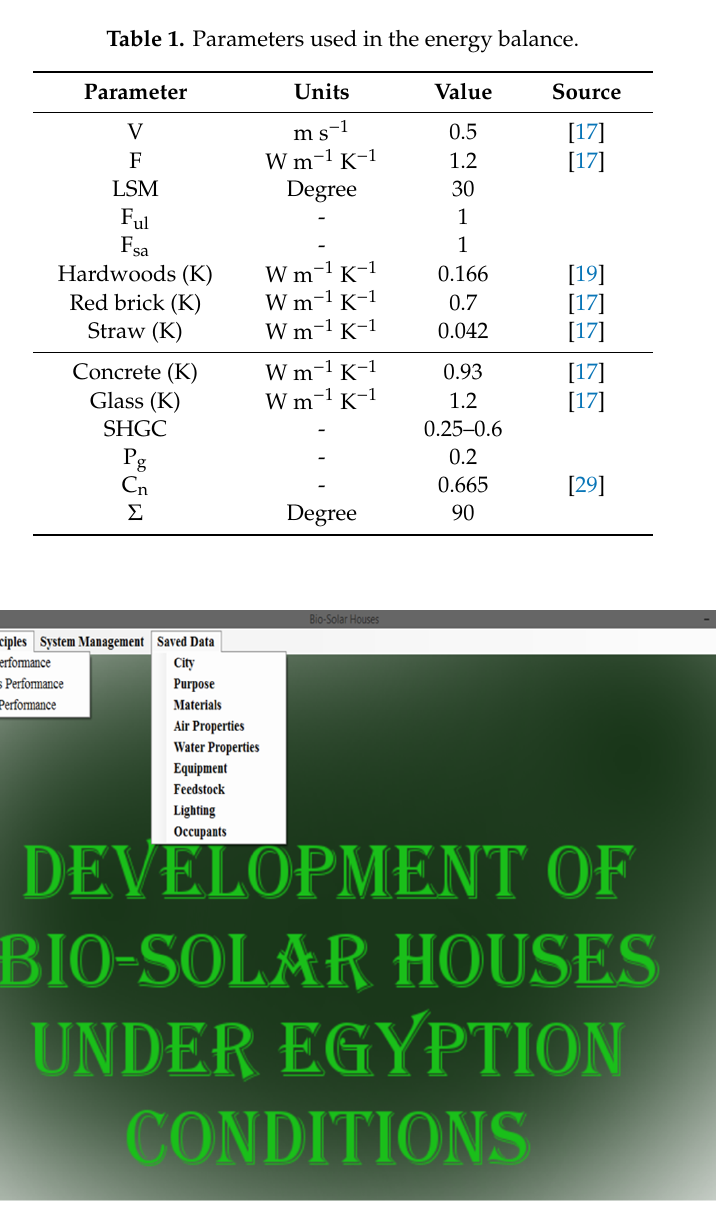
Table 1. Parameters used in the energy balance.